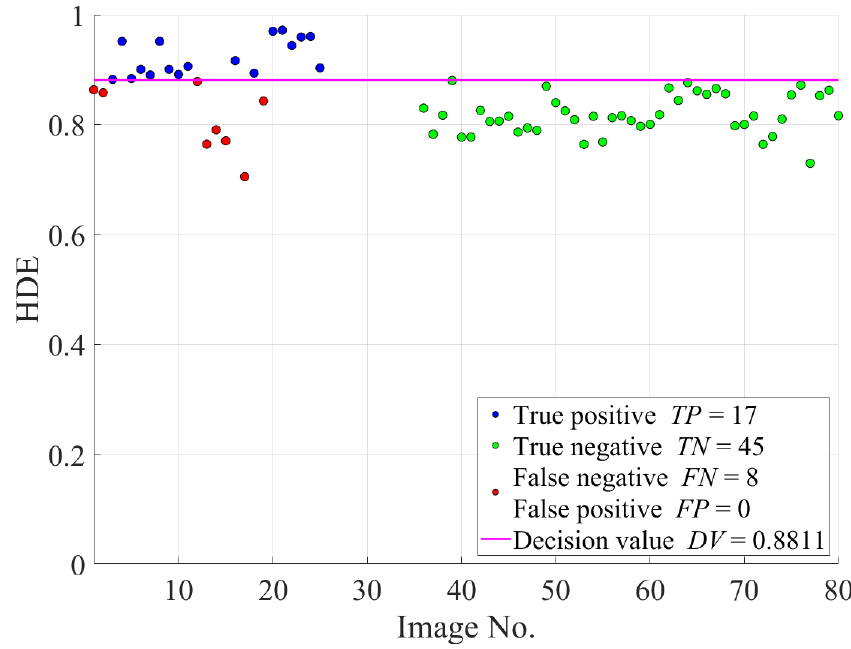
Figure 10. Scatter plot of the HDE values of images in the IVC and O-HAZE datasets after image intensity